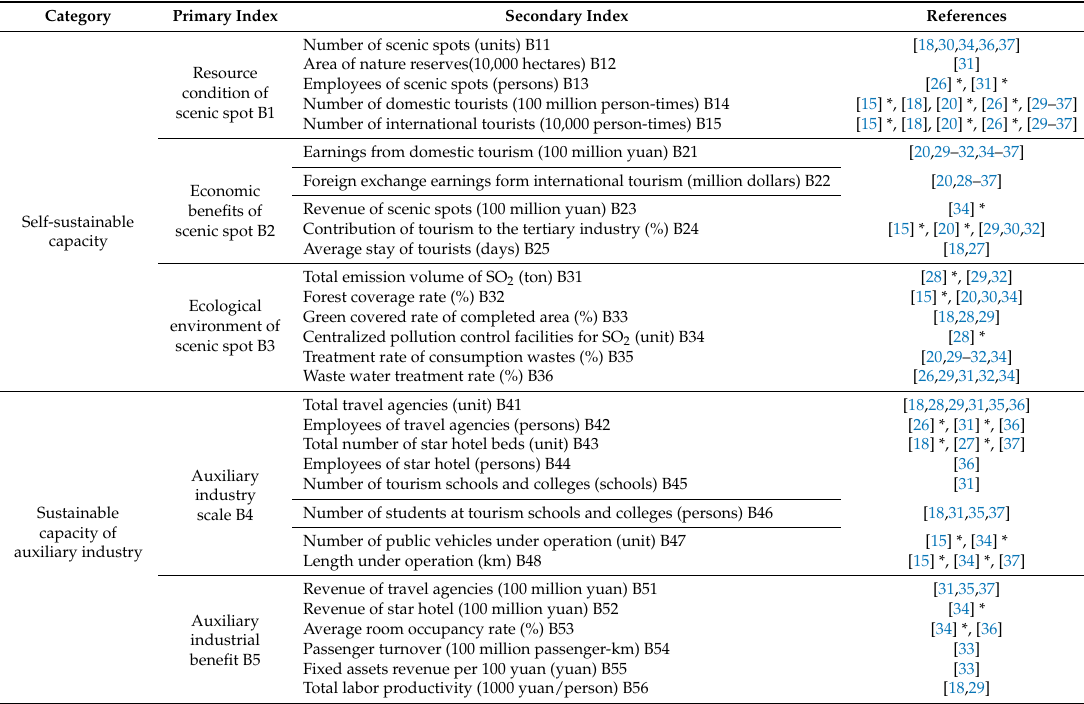
Table 1. Sustainable Development Measurement Index System of Scenic